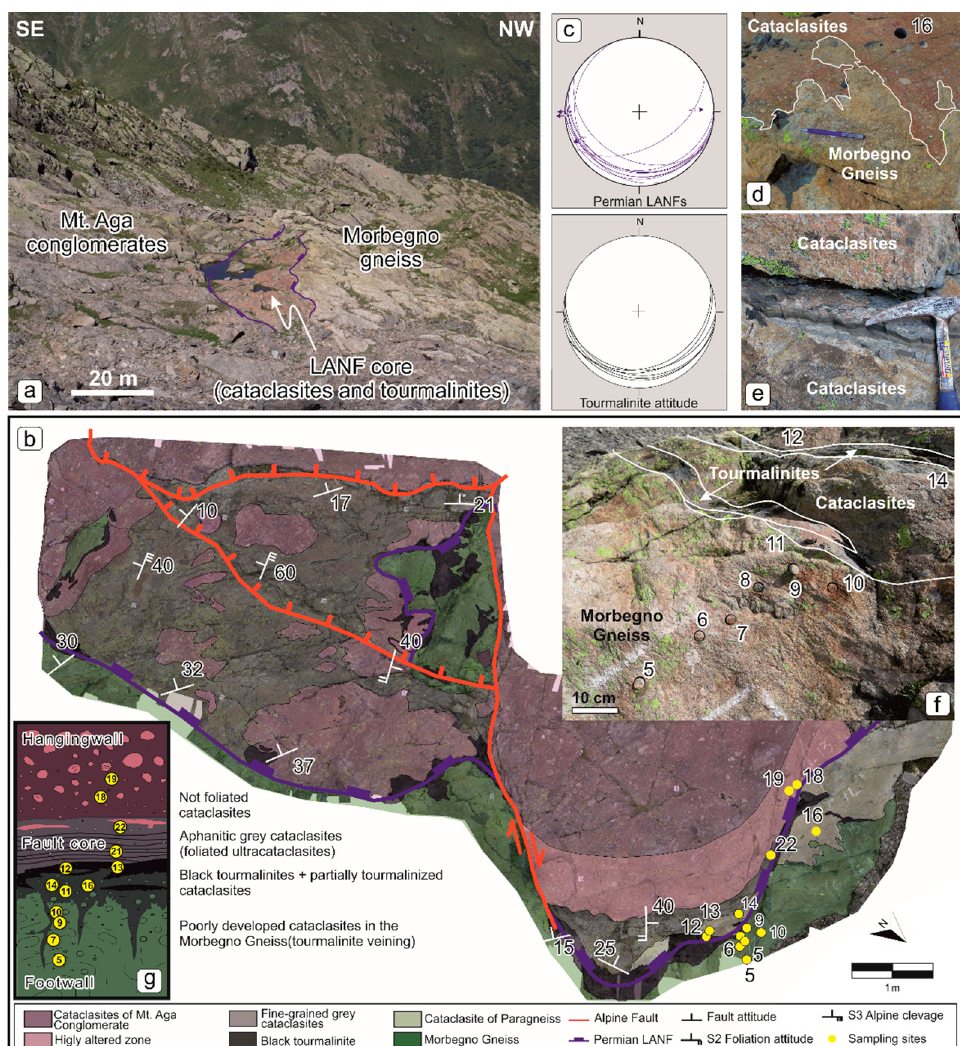
Figure 4. ( a ) The main outcrop viewed from the Forcellino Pass (see Figure 3 for location). ( b ) Detailed map of the outcrop exposing the preserved Permian fault structure. The map has been obtained from manual photogrammetric reconstruction of the outcrop. ( b ) Sketch of the LANF structure with sampling locations. ( c ) Attitude of tourmalinites layers and LANF slip planes. ( d ) The contact between crystalline basement and reddish cataclasites derived from the Mt. Aga conglomerates. ( e ) The typical banded texture of the fault core characterized by alternating black tourmalinites and gray cataclasites levels. ( e ) A detail of the sampling transect from the footwall trough the fault core. ( f ) Image of the sampled transect from the basement footwall across the fault core. ( g ) Reconstruction of the fault structure with sampling locations.